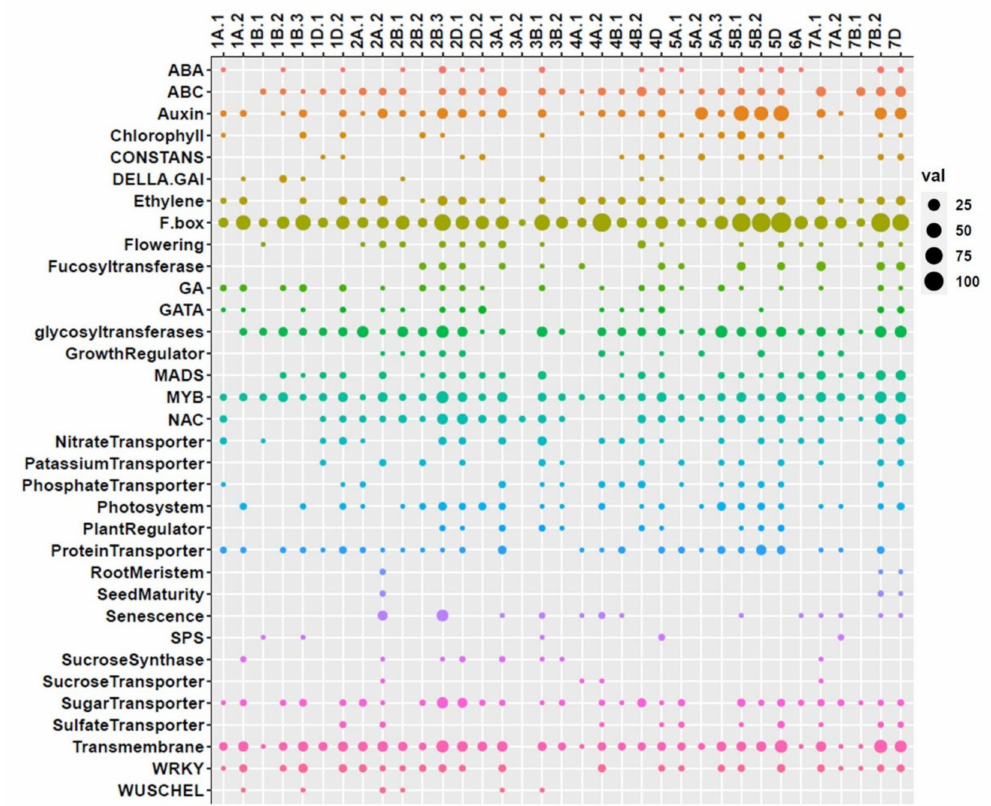
Figure 5. Potential candidate genes in QTL clusters in 18 wheat chromosomes. ABA: abscisic acid; ABC: ABC transporter ATP-binding protein ARB1; GA: gibberellin acid; GATA: GATA transcription factor; MADS: MADS-box transcription factors; MYB: MYB related transcription factors; NAC: NAC domain proteins; SPS: sucrose phosphate synthase; WRKY: WRKY transcription factors; WUSCHEL: WUSCHEL-like